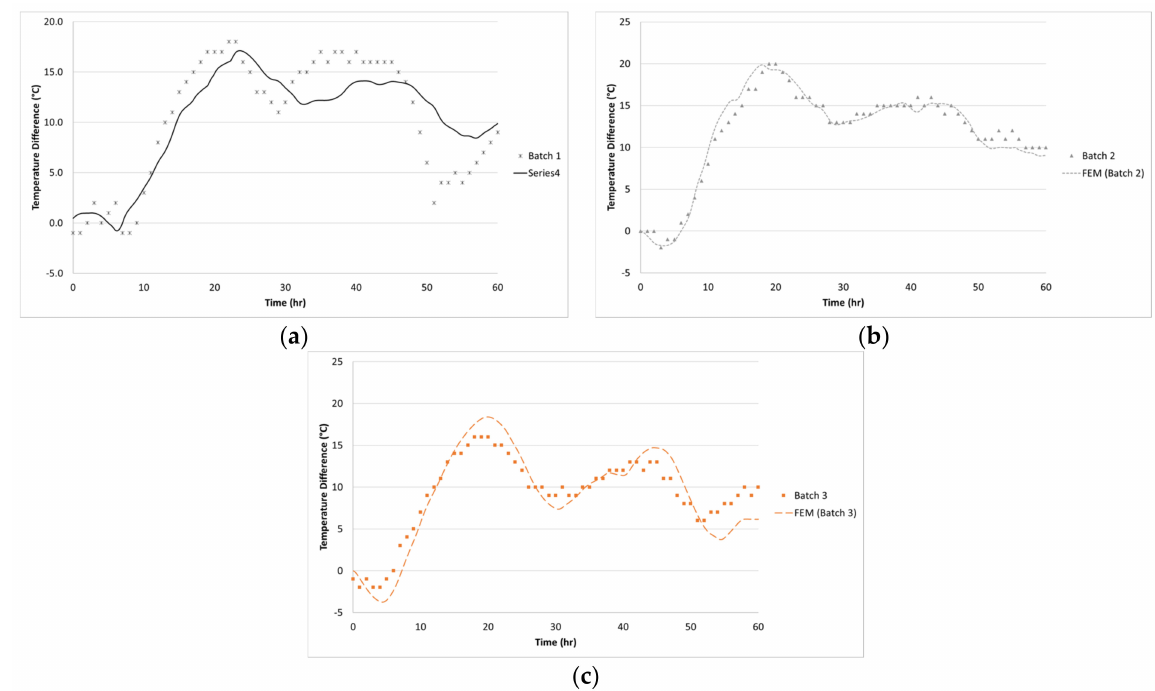
Figure 17. Comparison of the temperature difference between FEM model and experiment: ( a ) Batch 1, ( b ) Batch 2 and ( c ) Batch